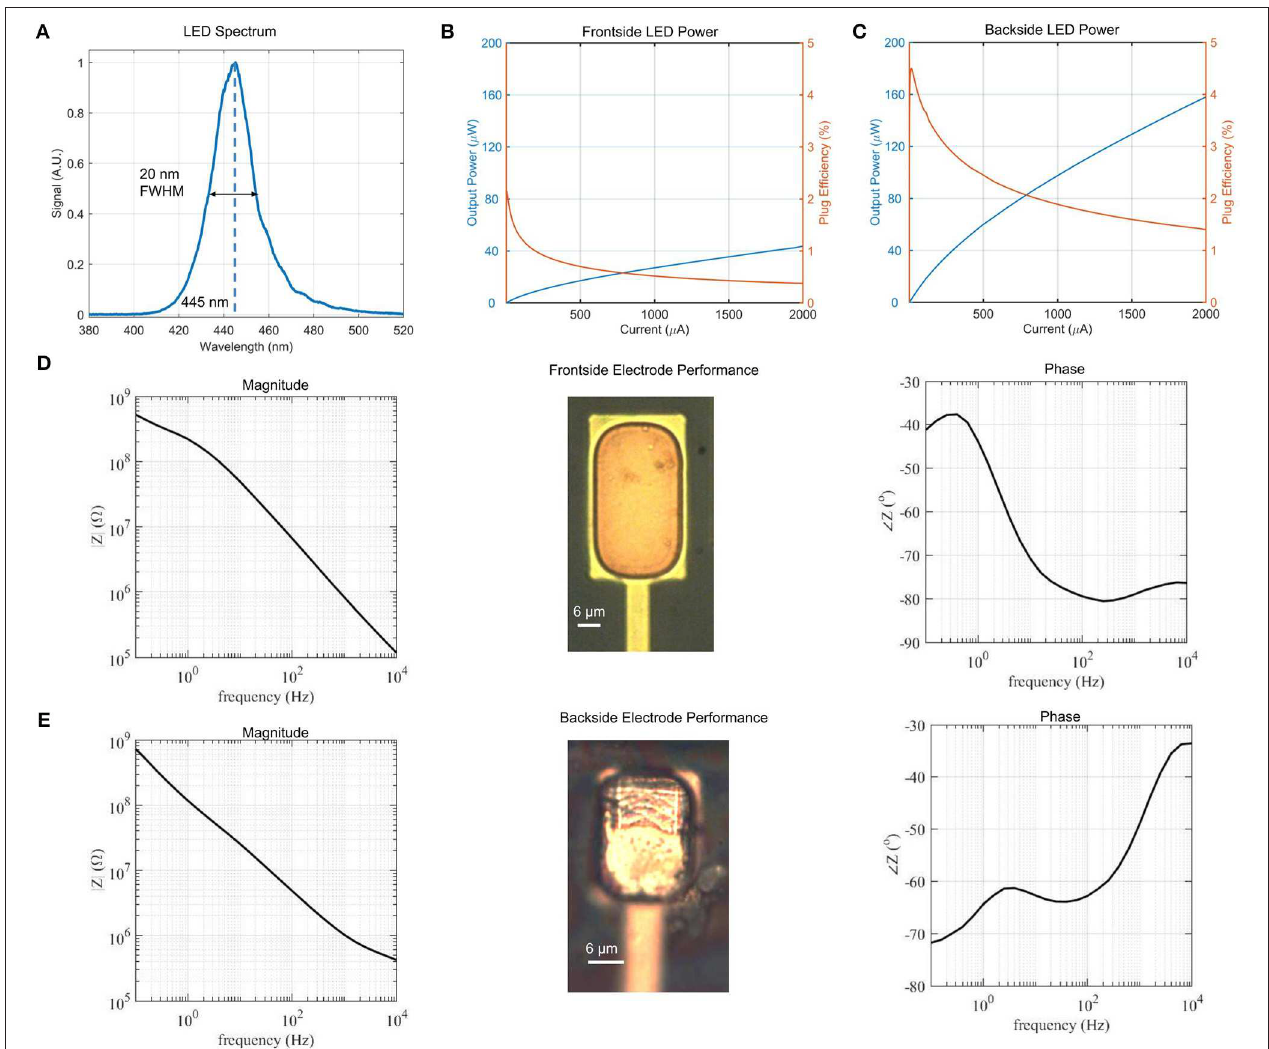
FIGURE 4 | (A) Micro-LED spectrum with peak intensity at λ = 445 nm and spectral linewidth of 20 nm FWHM, (B) Frontside and (C) Backside µ LED power and efficiency vs. drive current. Backside emission is approximately 4 times higher due to reflection from the topside metal contacts. Total efficiency of the µ LED structure for a given current is the sum of the frontside and backside efficiencies. Peak efficiency is therefore 6.5%. (D) Magnitude and phase plots of electrochemical impedance in the relevant frequency range of neural recordings for frontside electrodes. Inset image shows frontside electrode surface. (E) Magnitude and phase plots of electrochemical impedance for backside electrodes. Inset image shows backside electrode surface.